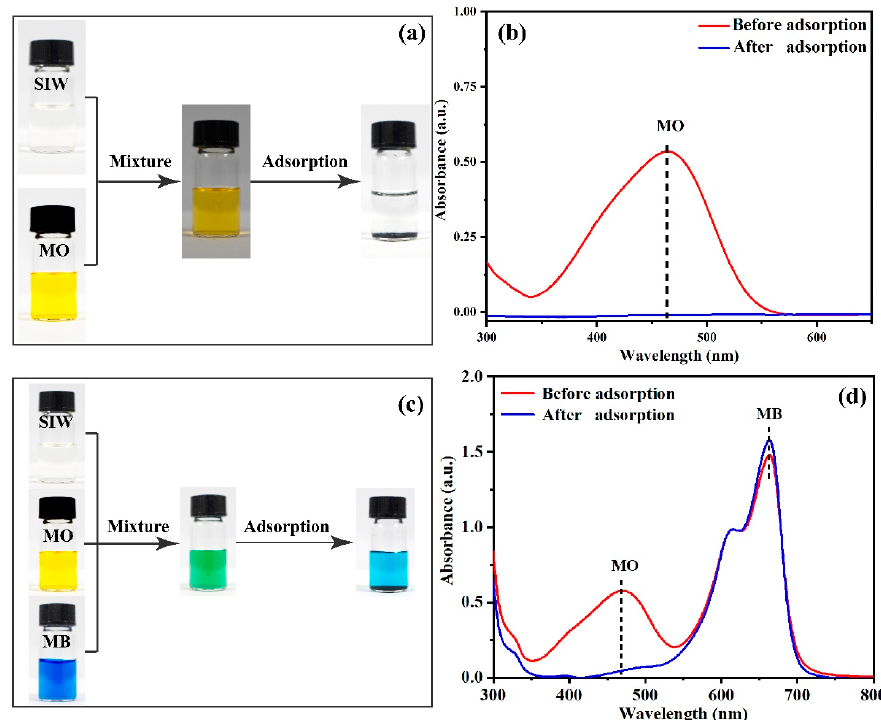
Figure 11. The photographs ( a ) and absorption spectra ( b ) of MO simulated industrial wastewater (SIW), and the photographs ( c ) and absorption spectra ( d ) of MO/MB-containing SIW before and after adsorption by PANI/PSMA.